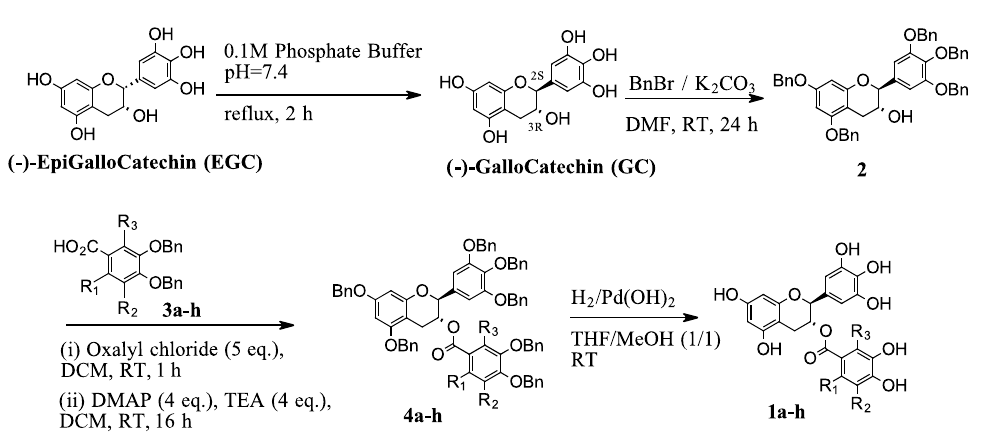
Figure 1. DYRK1A and DYRK1B inhibitors.